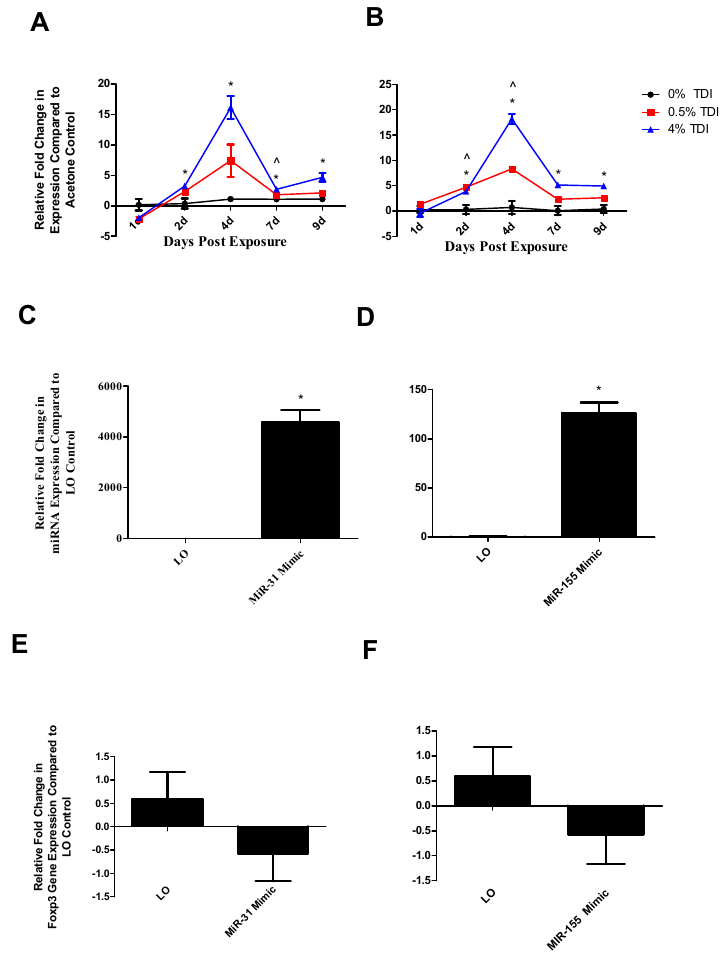
Figure 6. In vivo dLN miR-31 and -155 levels increase during TDI sensitization. Whole dLN miR-31 ( A ) and -155 ( B ) levels were quantified via RT-PCR at various time points post TDI sensitization. Statistical significance is represented by ˆ (0.5% TDI) and * (4% TDI) compared to vehicle control ( p < 0.05). Intracellular miR-31 ( C ), -155 ( D ) was quantified via RT-PCR in ex vivo stimulated samples (with miR-31 or -155 mimic addition, respectively) after 72 h. ( D – F ) foxp3 expression was investigated in cultures following miR-31 ( D ) and -155 ( E ) mimic treatment. Statistical significance is represented by * when compared to lipofectamine only (LO) control ( p < 0.05). ( n =